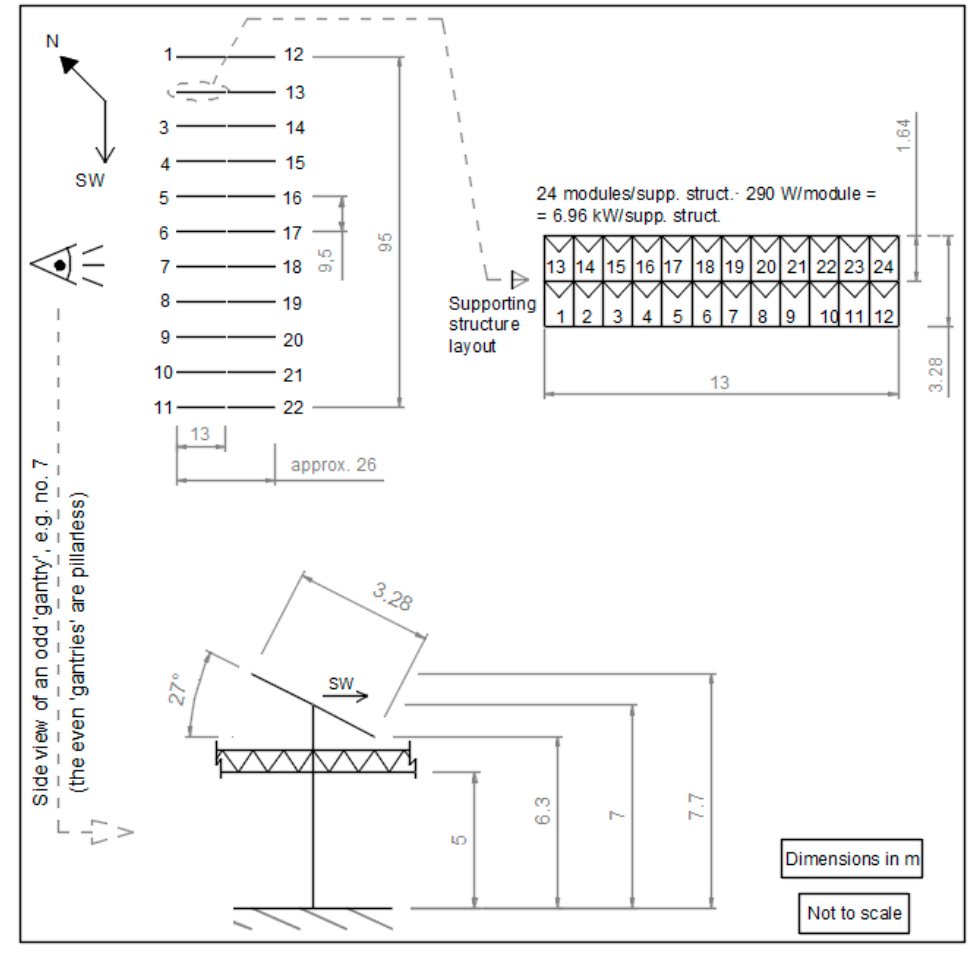
Figure 2. Basic Southwest-oriented agrophotovoltaic shed featuring an installed PV capacity of 153.1 kWp and connected to a 150 kW inverter.